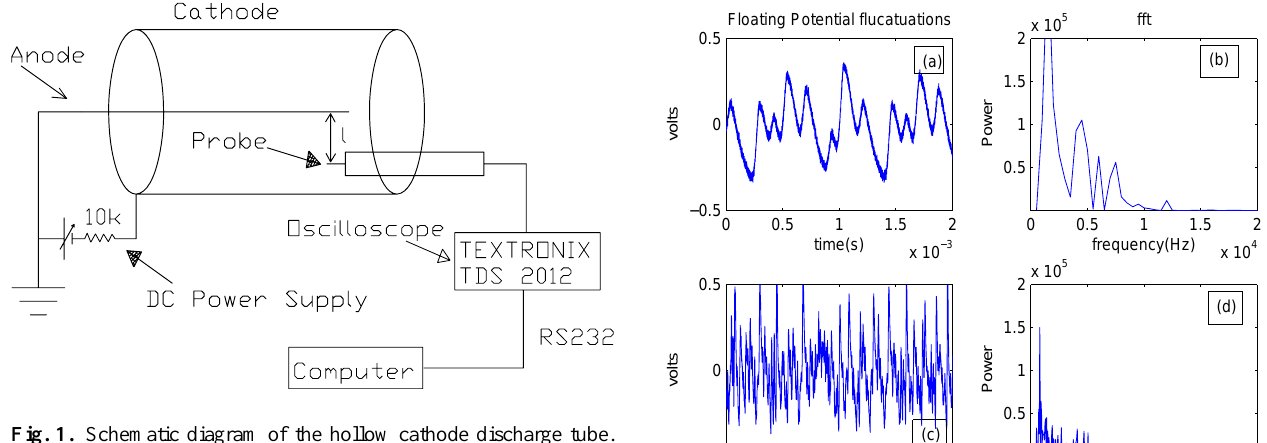
Fig. 1. Schematic diagram of the hollow cathode discharge tube. The cathode and the anode are a hollow tube and a wire of stainless steel, respectively.